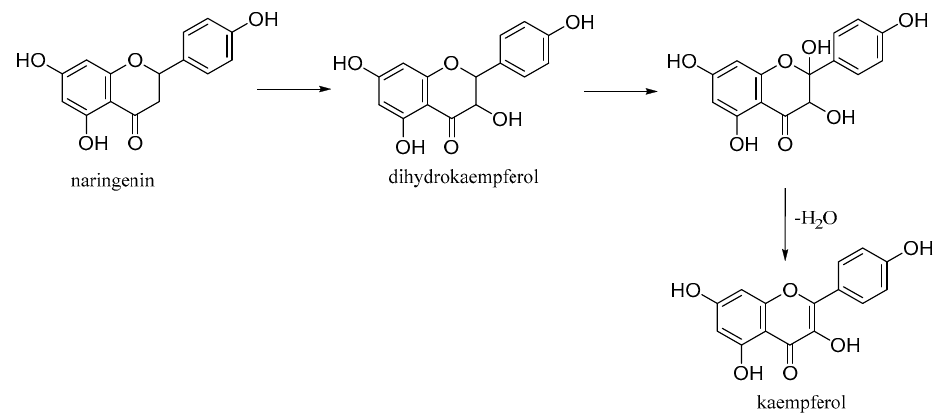
Figure 11. Biosynthetic pathway of apigenin.